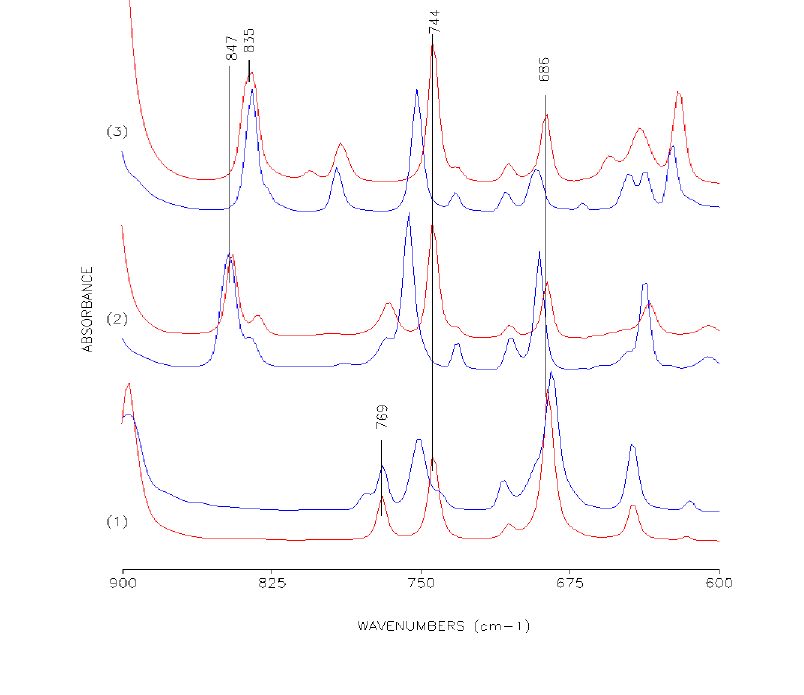
Fig. 5 900 { 600 cm ¡ 1 IR spectra of PTB (1), 4’-CNPTB (2) and 4’-MePTB (3); ( ) { in solid state, ( ) { carbon disul› de